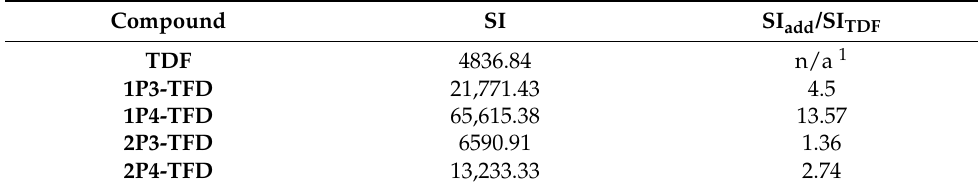
Table 3. Antiviral activity of TDF and mPEG-b-PEPA adducts of TFD.